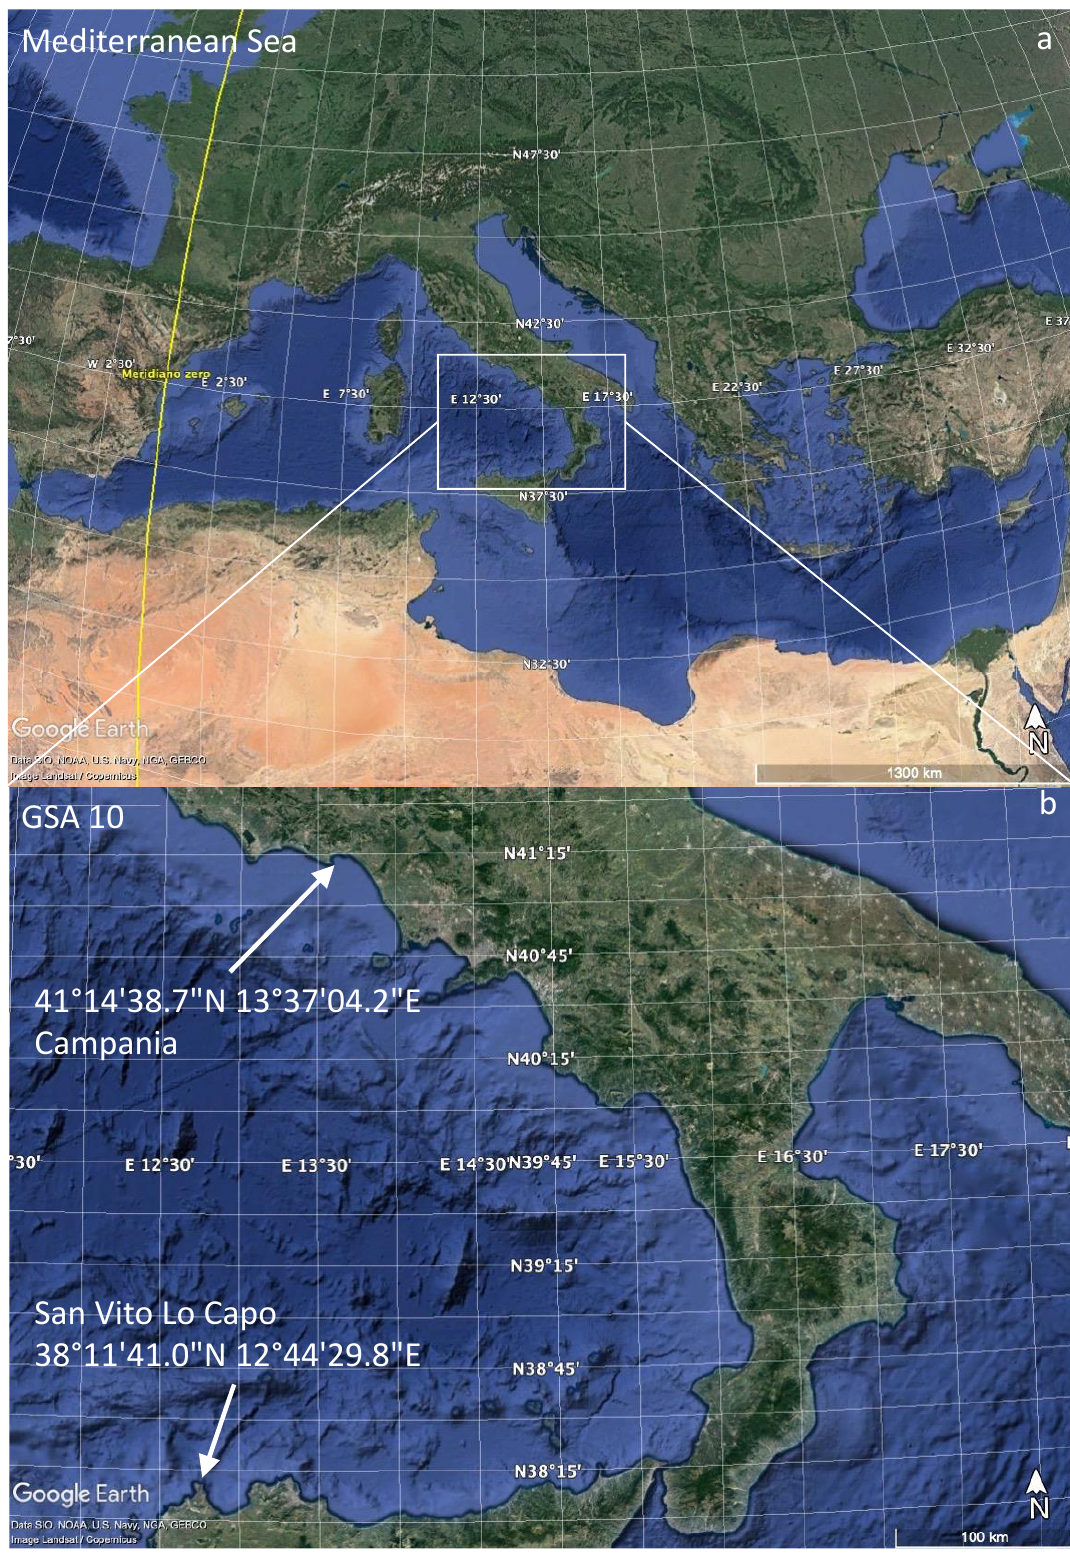
Figure 1. Maps of the Mediterranean Sea ( a ) and the subarea studied (GSA 10) ( b ). In ( b ), the white arrows indicate northern and southern GSA geographical border points with their relative coordinates.